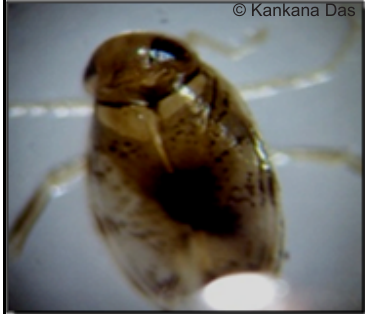
Image 1. Micronecta haliploides